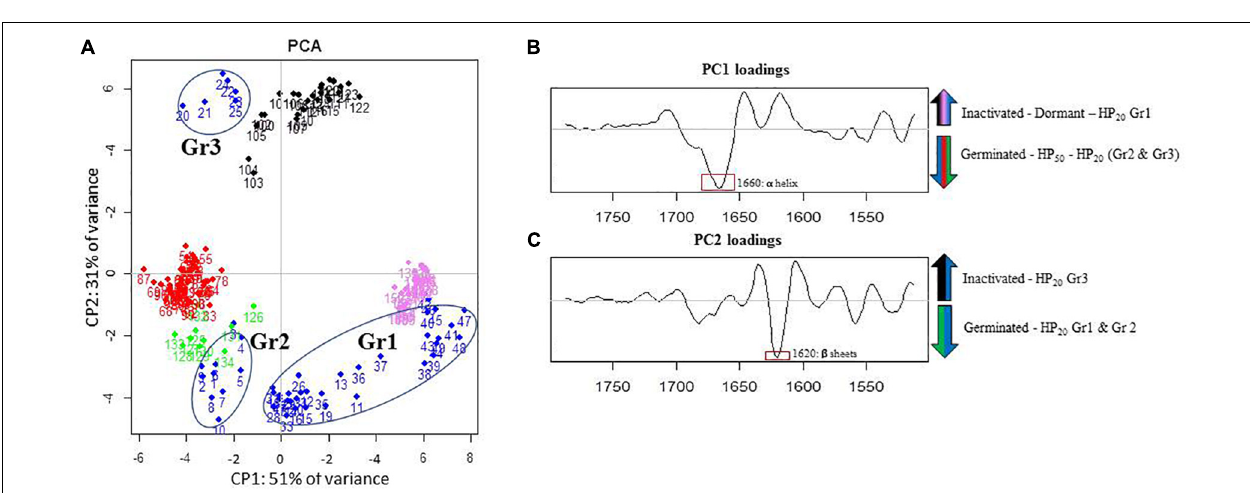
FIGURE 5 | Second derivative of the mean infrared spectra of control spore samples (germinated; dead; dormant) and spores treated by high pressure (HP) at 500 MPa for 10 min at 50 ◦ C or 20 ◦ C. (A) Second derivative spectra in the spectral domain 2,950–2,990 cm − 1 ; (B) Second derivative spectra in the spectral domain 2,870–2,830 cm − 1 .